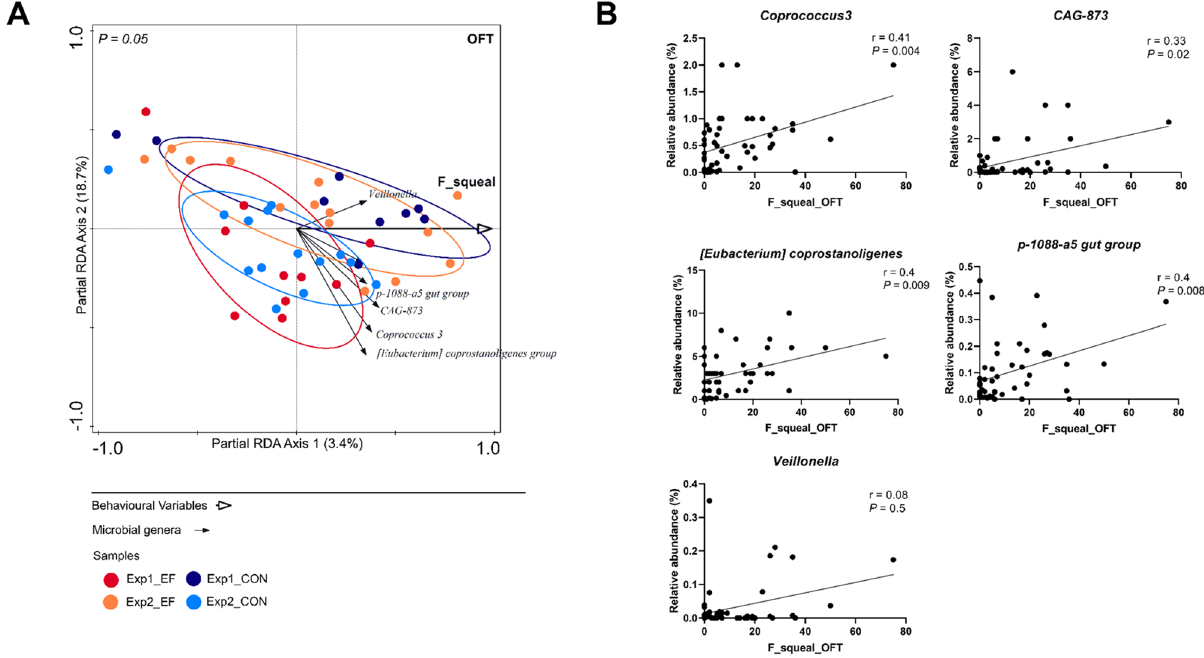
Figure 2. Assessing microbial associations of individual behavioural variables in open field test (OFT). ( A ) Partial redundancy analysis (pRDA) of the frequency of squeals (F_squeal_OFT), corrected for experiment and treatment. In the pRDA triplot, individual animals are indicated in coloured balls belonging to either one of the experiments and treatment group. Microbial groups having (1) RDA response score ≥ 0.35 as well as (2) minimum 0.1% relative abundance in at least 10% of the samples, are visualised in the triplot. The perpendicular distance between microbes and environmental variable axes in the plot reflects their correlations. The